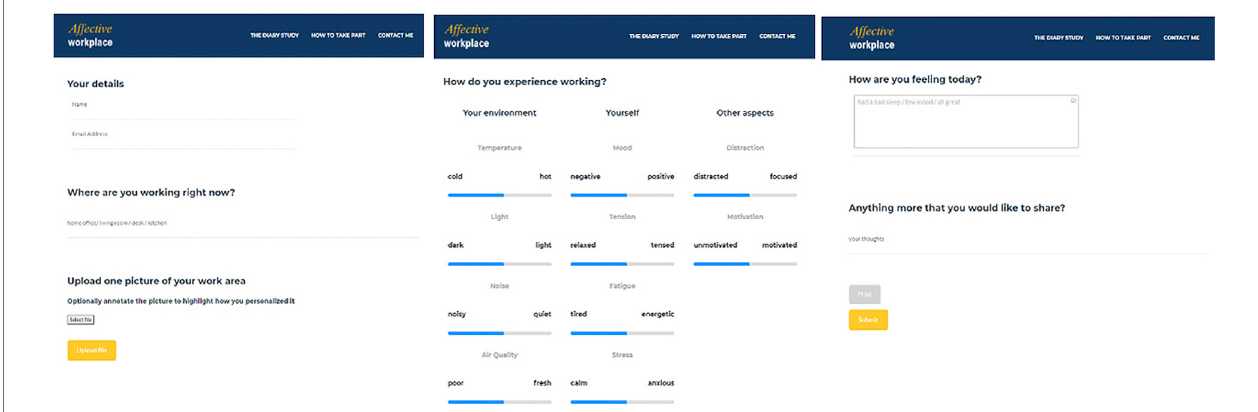
FIGURE 1 | The purpose-build